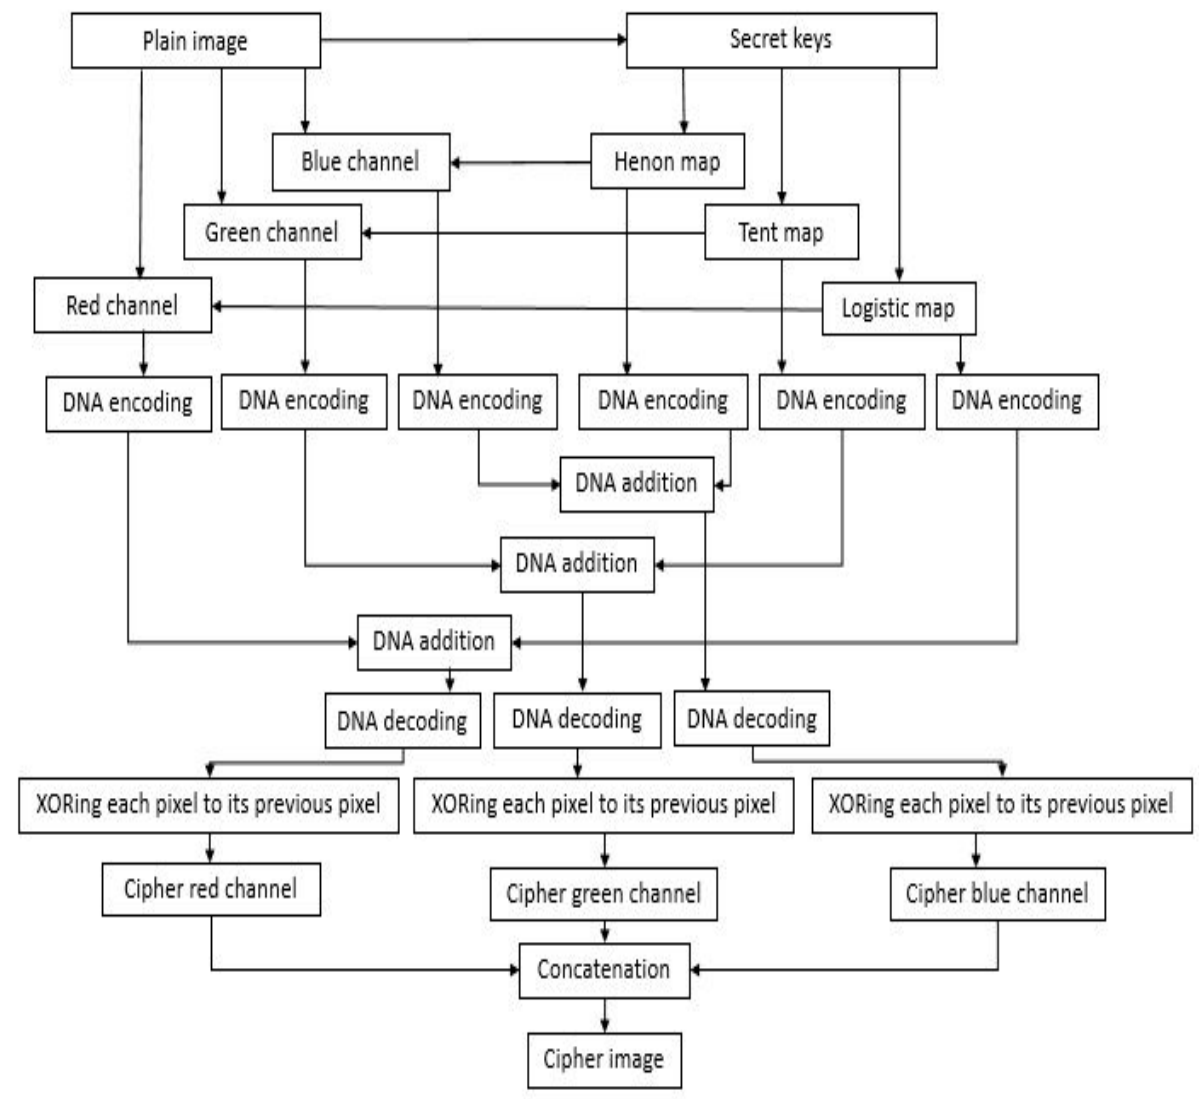
Figure 1. Block diagram of the proposed encryption scheme